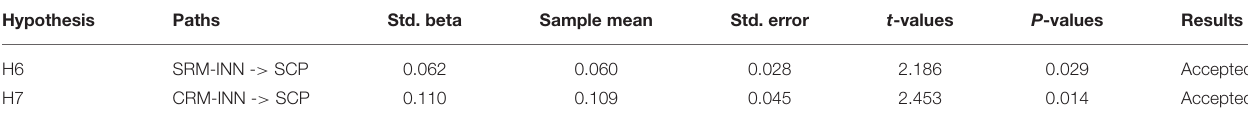
TABLE 7 | Indirect relationships between customer relationship management, innovation, supplier relationship management and supply chain performance ( N = 208). Hypothesis